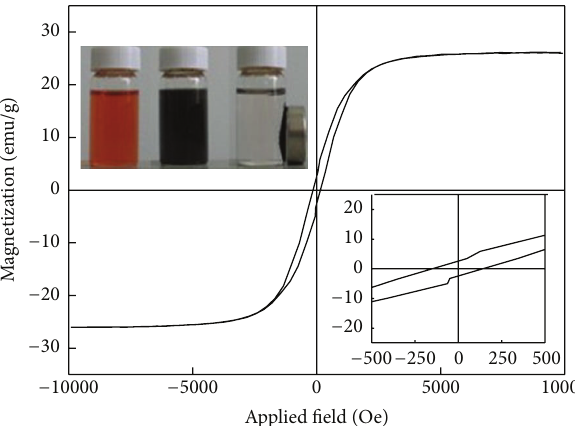
Figure 4: Magnetic hysteresis curve of Ni nanoparticles. Inset in turn is CR solution, mixing with the magnetic absorbents and sep- aration of the adsorbent from solution with a magnet after adsorp- tion,